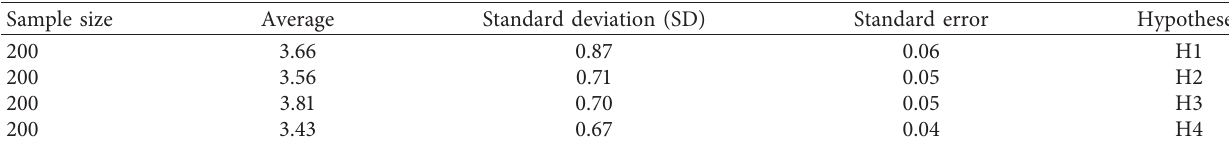
Table 14: Statistics related to the first